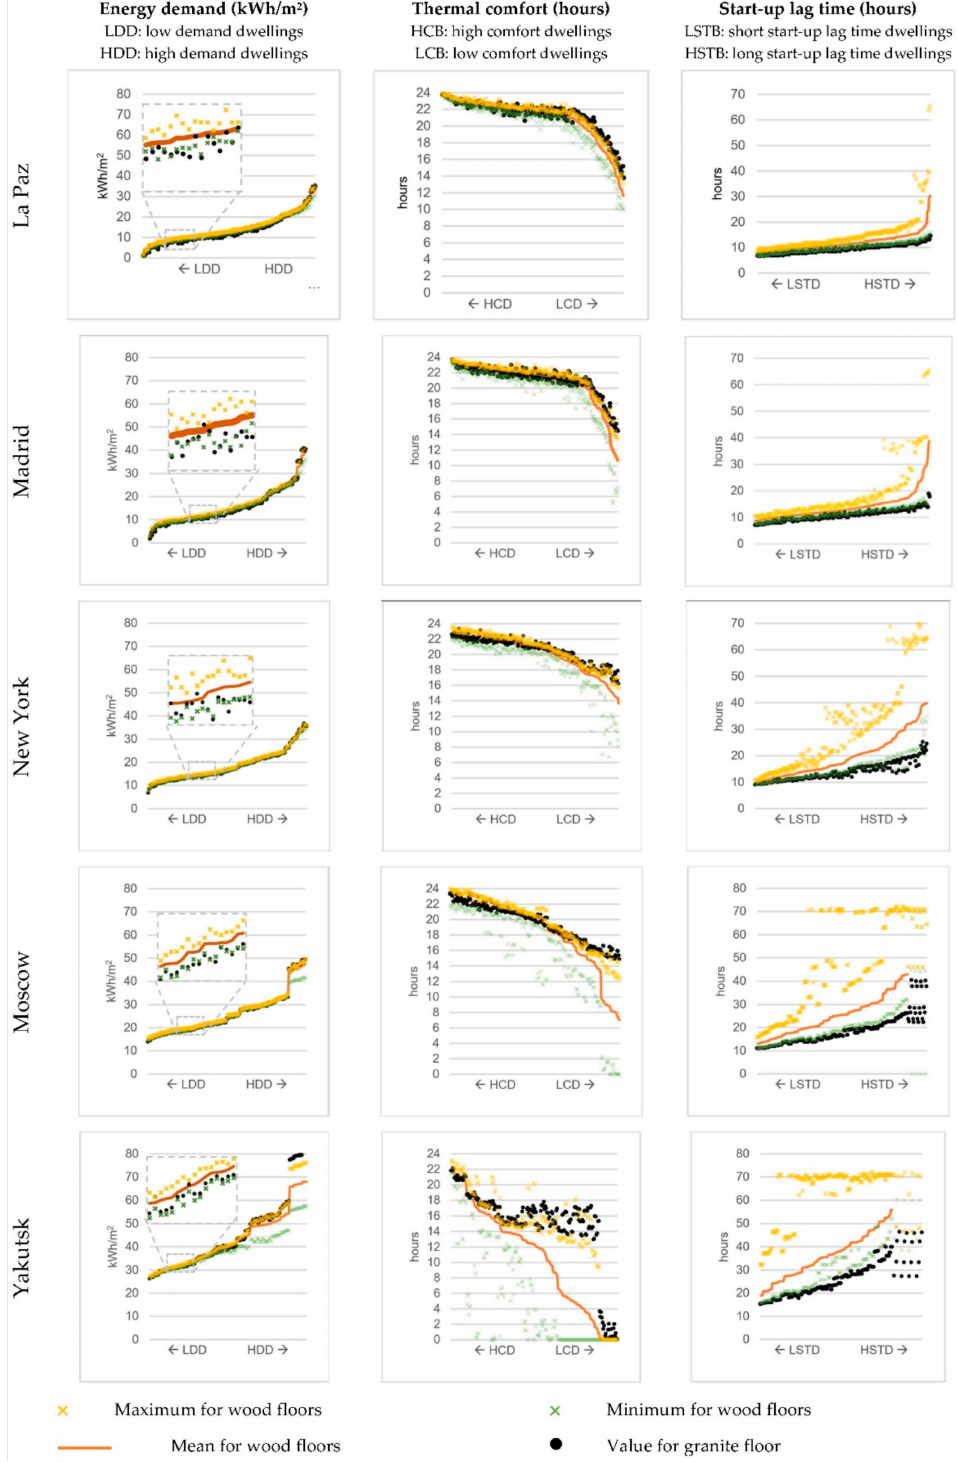
Figure 7. Energy demand, thermal comfort, and start-up lag time in the 216 dwellings in each of the five selected representative